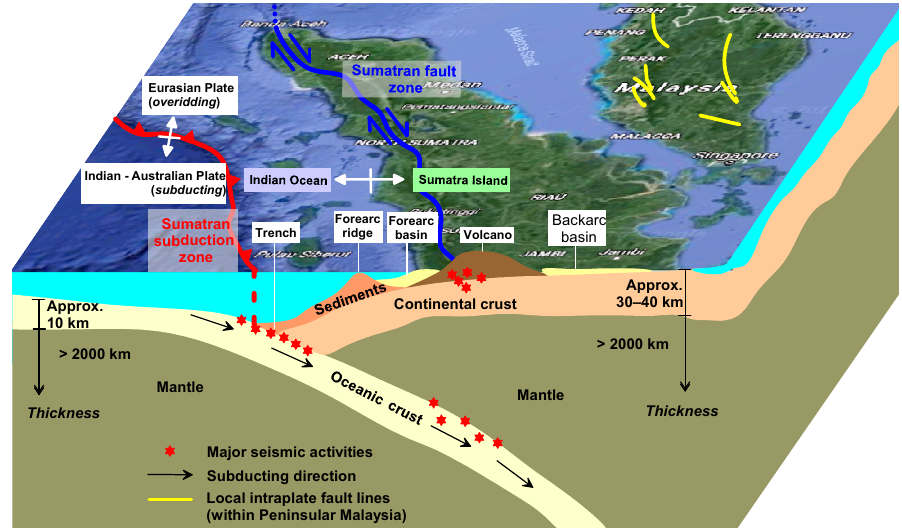
Figure 2. Schematic cross section of A–A from Fig. 1 showing the subduction of Indian–Australian Plate beneath the Eurasian Plate and the location of major seismic activities along the Sumatra subduction and fault zone. The diverging white arrows merely indicate the separation between the Eurasian Plate and the Indian–Australian Plate; and also the Indian Ocean and